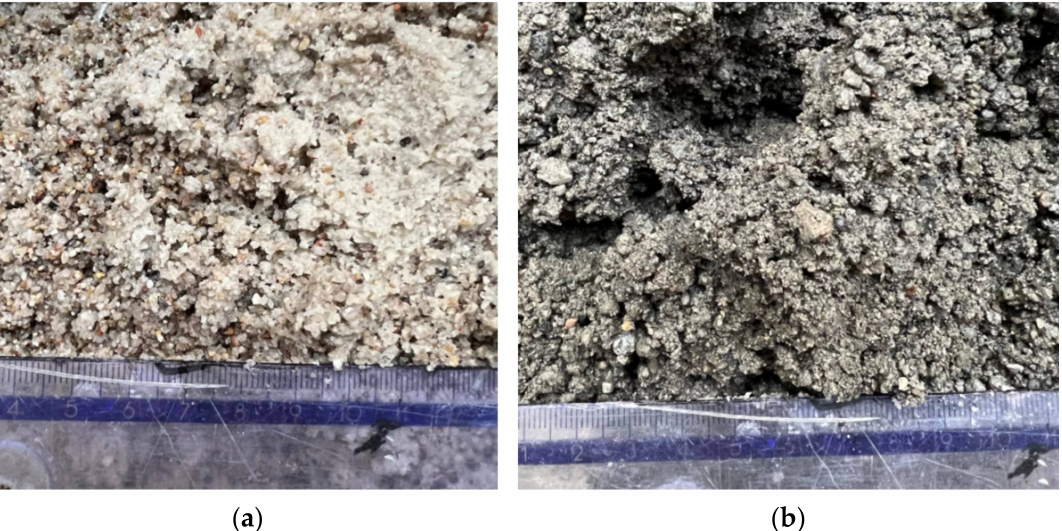
Figure 7. Comparison of water absorption to sand and sand substitute (MSWIBA) used in geopolymer mix: ( a ) sand; ( b )